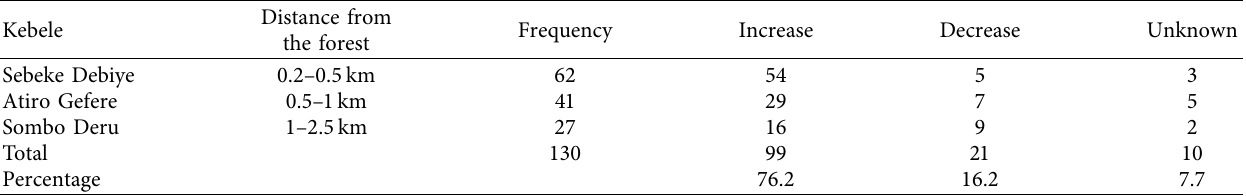
Table 4: Te approximate distance between farmland and forest, as well as the trend of crop feeding by primates. Distance Kebele